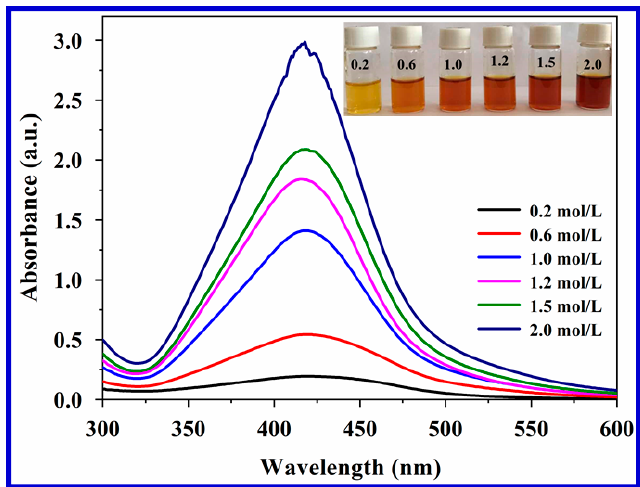
Figure 1. UV-Vis spectra of carrageenan-silver nanoparticles (AgNPs) prepared with different concentrations of Ag + . Reaction conditions: 0.5% carrageenan, 90 °C, 4 h. Inset: photographs of carrageenan-AgNPs.